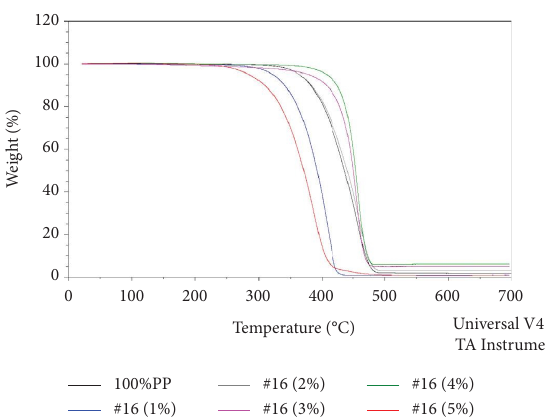
Figure 5: TGA graph for pure PP and #16 samples.